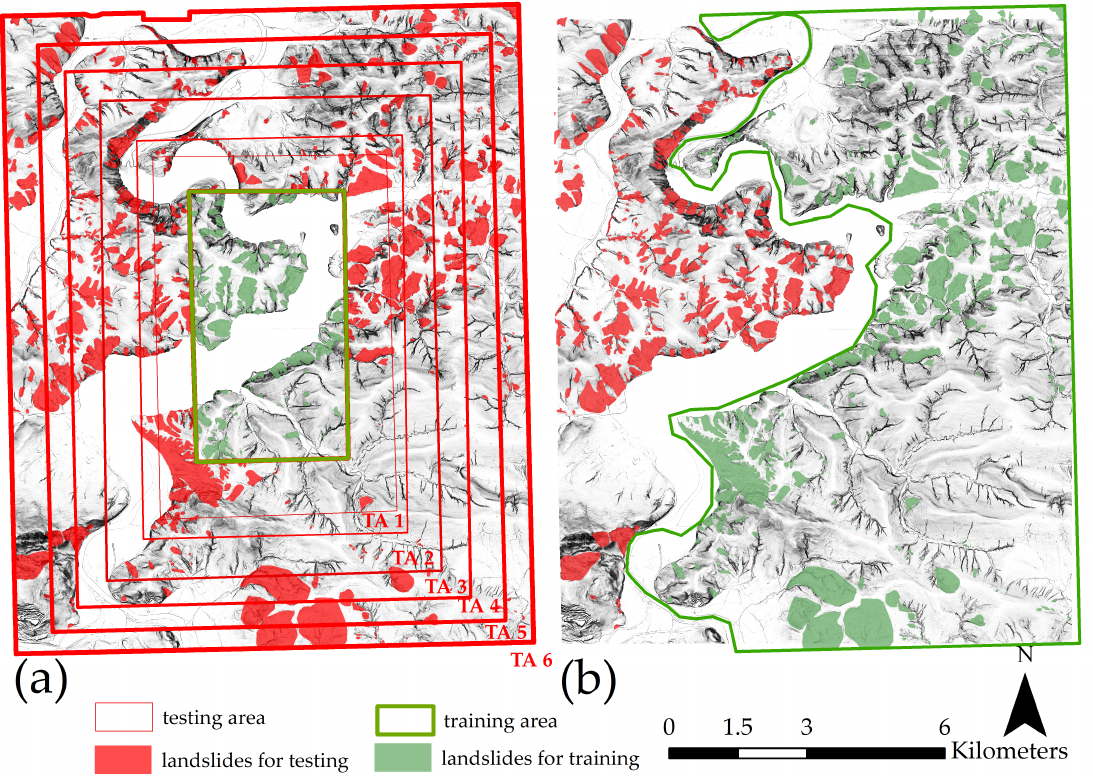
Figure 5. Various training and testing strategies used: ( a ) region growing testing design with various testing areas abbreviated as TA 1–6 and ( b ) natural boundary splitting design (the right green area used for training and red left area used for testing). Table 3. Overview of the applied training sample size in the region growing testing